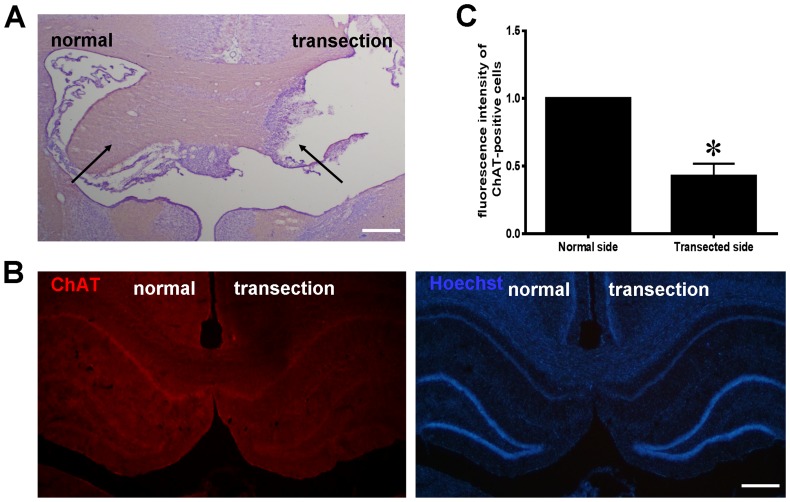
Confirmation of the FiFx transection model.(A) Nissl staining of a coronal section through the FiFx at day 7 after right FiFx transection. Arrows show loss of the right FiFx whereas the left FiFx remains intact (n = 10; a representative panel is shown). (B) ChAT immunofluorescence staining of coronal section through hippocampus at day 7 after right FiFx transection. (C) Quantification of fluorescence intensity of ChAT-positive cells in the transected or normal side. The normal side set to 1. *, P<0.05. Scale bar, 300 µm.